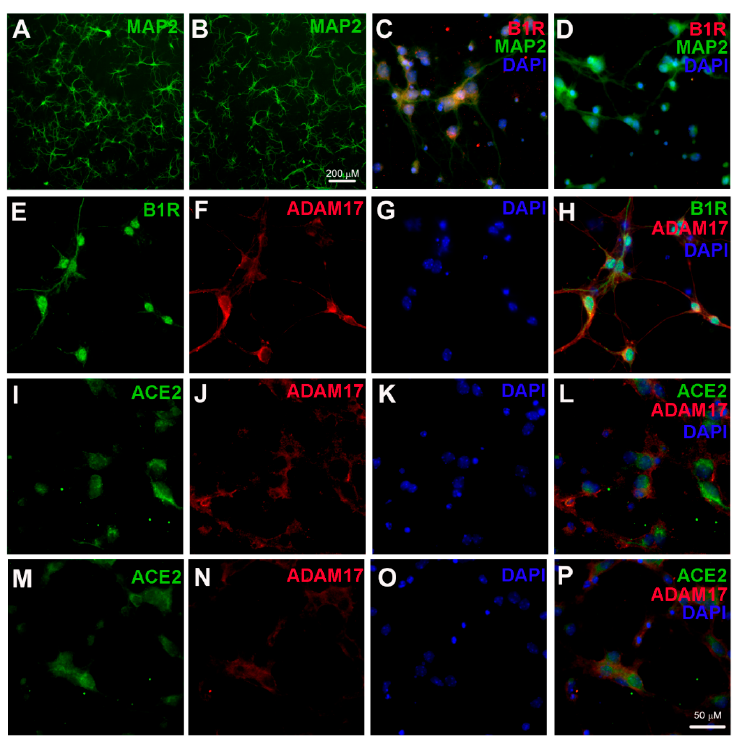
Figure 1. Kinin B1 receptor (B1R), A Disintegrin And Metalloprotease 17 (ADAM17), and angiotensin converting enzyme 2 (ACE2) expression in primary hypothalamic neurons. Representative photomicrographs showing immunofluorescence staining for neuron-specific marker microtubule associated protein 2 (MAP-2) (Green) in primary neurons from wild-type ( A ) and B1R knockout mice ( B ) cultured for 10 days. Primary neurons from wild-type mice pups showed immunopositivity for the presence of B1R ( C ), while B1R immunoreactivity was absent in neurons with B1R deletion ( D ). Representative triple immunostaining revealed that kinin B1R ( E ) and ADAM17 ( F ) are expressed in primary hypothalamic neurons expressing nuclear DAPI staining in blue ( G ), and merged image ( H ) shows the colocalization of B1R and ADAM17. Representative triple immunostaining showing ACE2 and ADAM17 expression and co-localization in wild-type neurons ( I – L ) and in B1R knockout neurons ( M – P